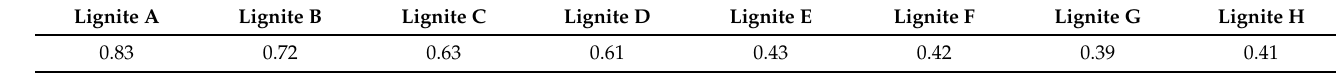
Table 5. The average of normalized Combustion